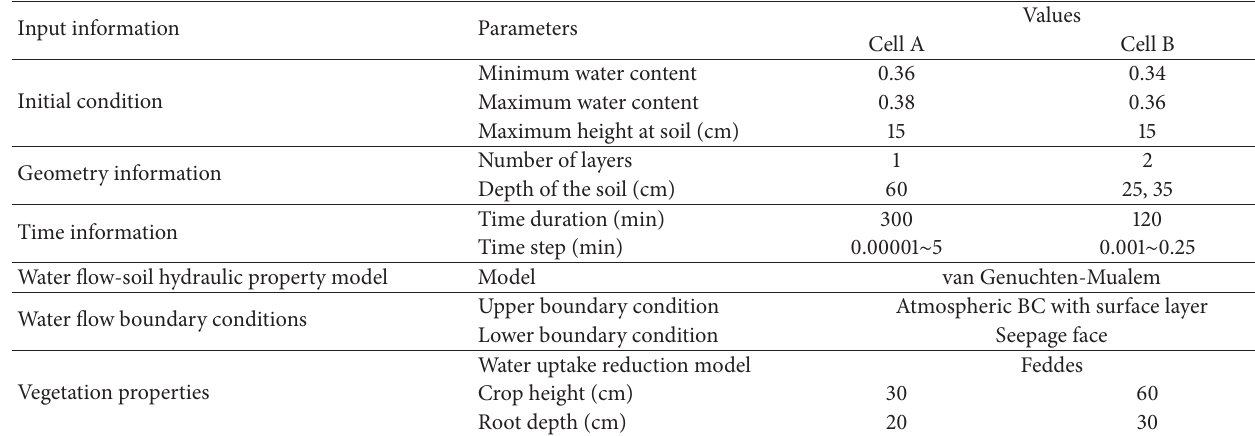
Table 1: The input information in the model for Cells A and B.